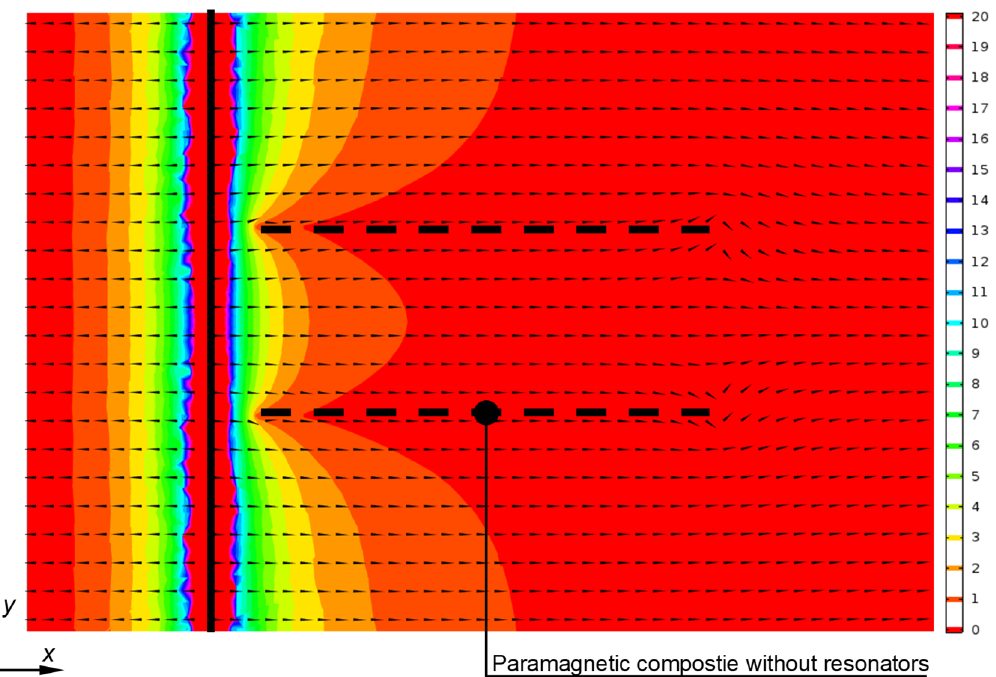
Figure 7. Magnetic field norm (color) and normalized power flow (black arrows) for the model with the paramagnetic cladding (the highest considered permeability, µ m = 150) without resonators.